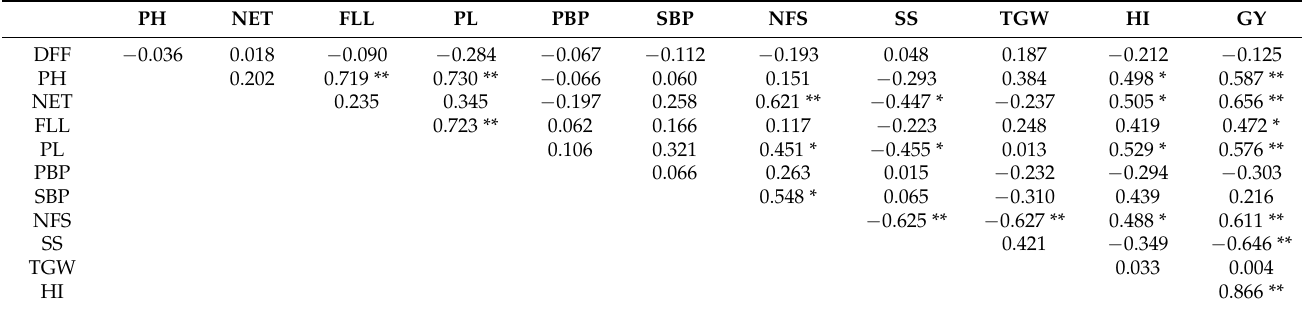
Table 3. The genotypic correlation coefficient among 12 characters in 20 genotypes of T. Aman rice.